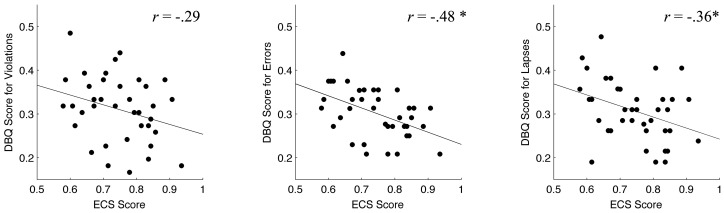
Scatter diagrams of Effortful Control Scale (ECS) score and Driving Behavior Questionnaire (DBQ) scores.Panels A, B and C denote DBQ scores for violations, errors and lapses, respectively, during daily driving. Each dot represents each participant. Asterisks indicate statistically significant correlations (P<0.05/3; one-tailed Pearson's correlation test adjusted by the Bonferroni correction for multiple comparisons).